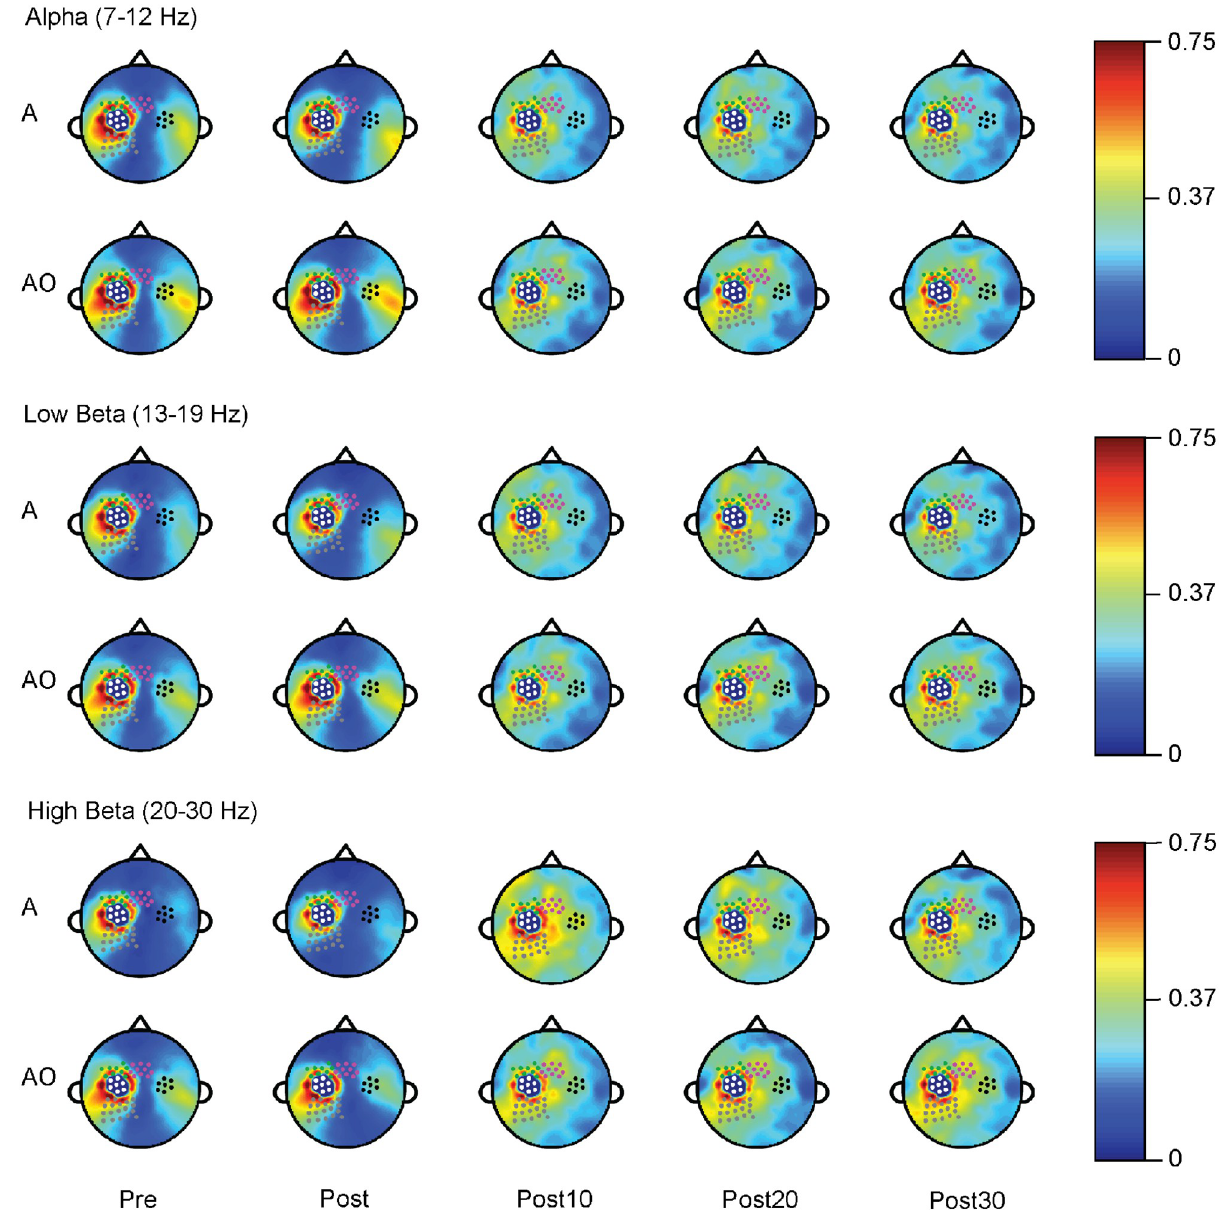
Fig 2. EEG coherence pre/post priming. Aerobic exercise (A) and action observation (AO) priming resulted in enhanced EEG coherence in alpha (7– 12 Hz, top), low beta (13–19 Hz, middle), and high beta (20–30 Hz, bottom) frequency bands most pronounced at 10, 20, and 30 minutes post-priming (Post10, Post20, and Post30). White leads represent the coherence seed region overlying left primary motor cortex. Black leads denote right primary motor cortex, grey leads denote left parietal cortex, green leads denote dorsal premotor cortex, and magenta leads denote supplementary motor area.